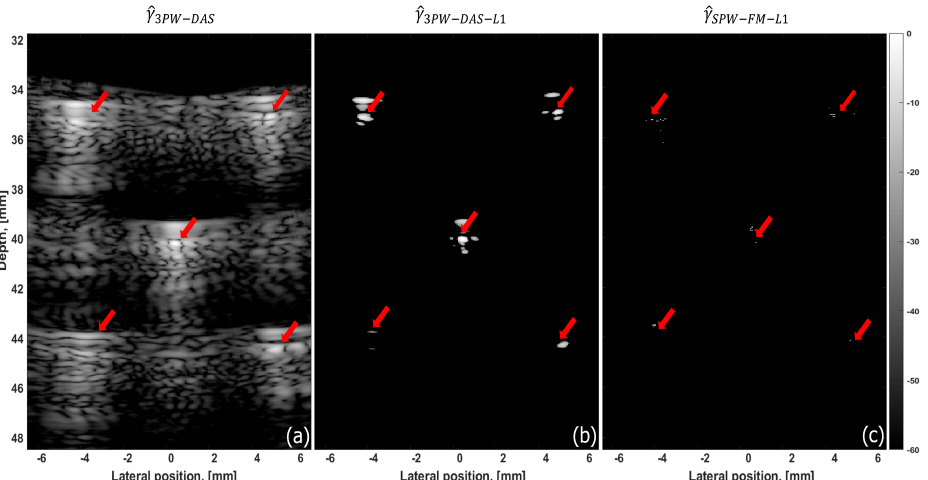
Figure 8. Estimation of the wires TRF. ( a ) Estimated using the delay and sum algorithm ( ˆ γ 3PW-DAS ). ( b ) Estimated using (cid:96) 1 denoising on ˆ γ 3PW-DAS . ( c ) Estimated using the proposed approach ( ˆ γ SPW-FM-L1 ). The physical location of the scatterers is indicated by the red arrows. It can be seen that for parts a and b, an additional step of envelope detection is applied before log −